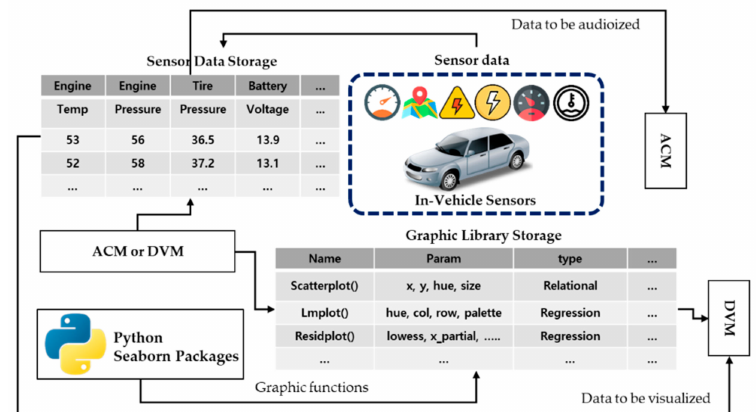
Figure 2. Structure of a data collection and management